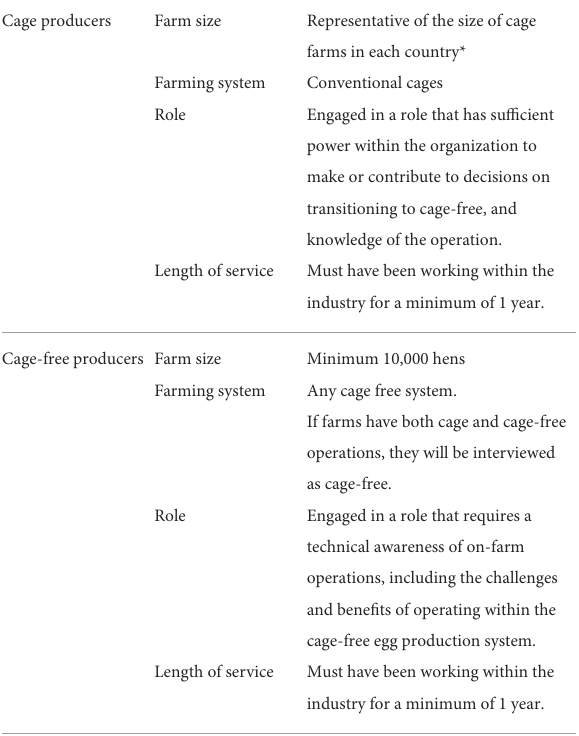
TABLE 1 Participant eligibility